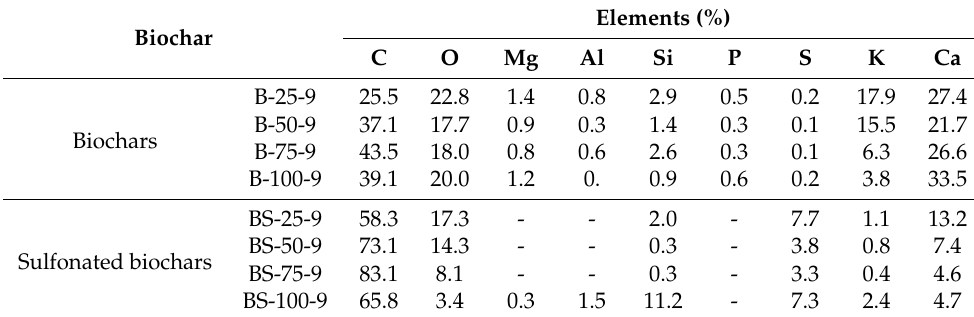
Table 3. Elemental composition of the biochars obtained at 900 ◦ C.